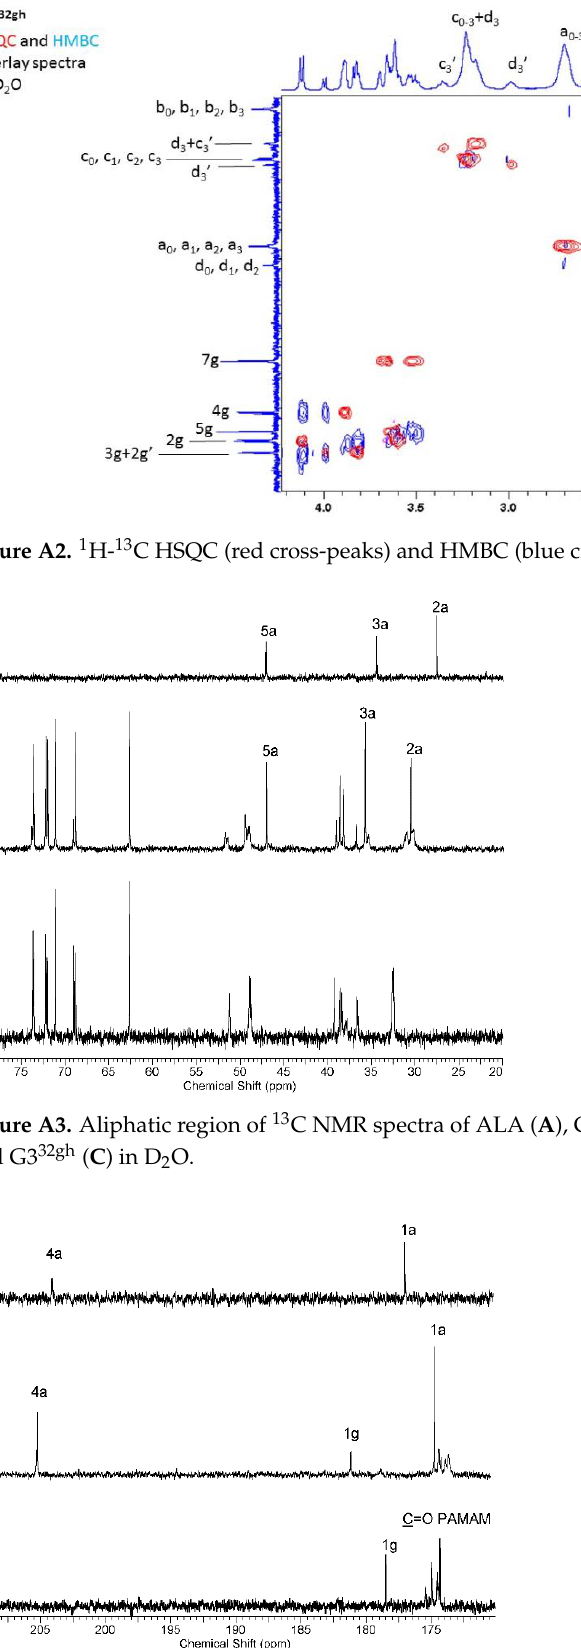
Figure A4. Downfield region of 13 C NMR spectra of ALA ( A ), G3 32gh and 8 equivalents of ALA ( B ), and G3 32gh ( C ) in D 2 O.